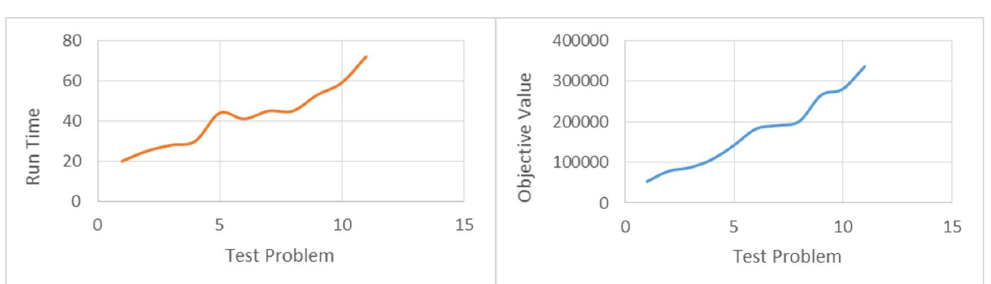
Fig. 14. Objective value and run time for scenario 5